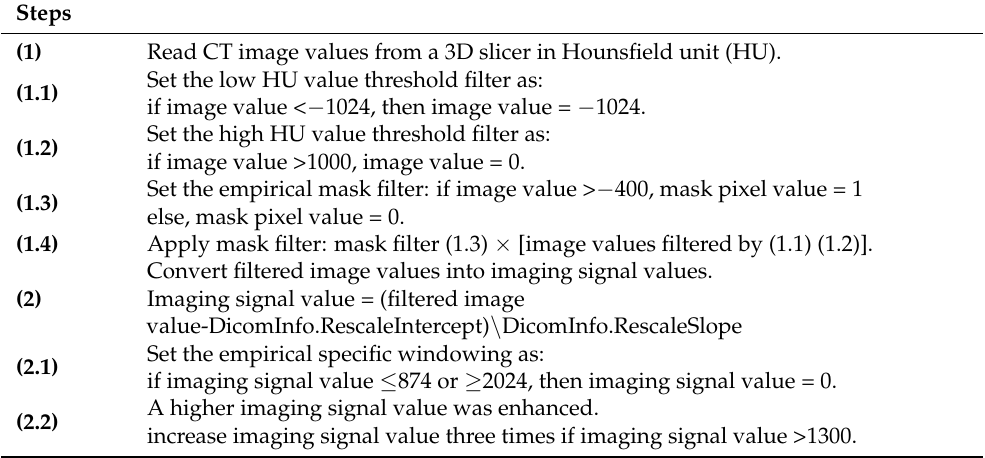
Table 3. Algorithm of enhanced bone signals.